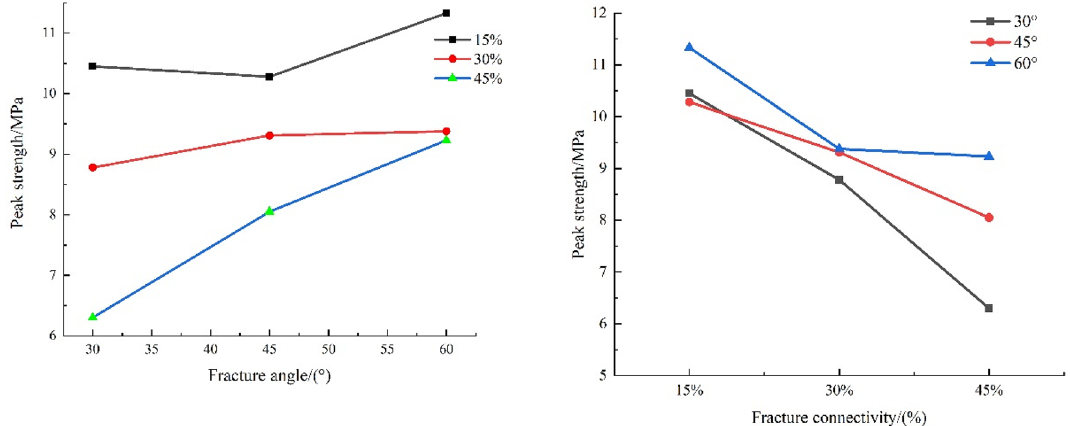
Figure 8. Effect of fracture angle and connectivity on the peak sample strength.